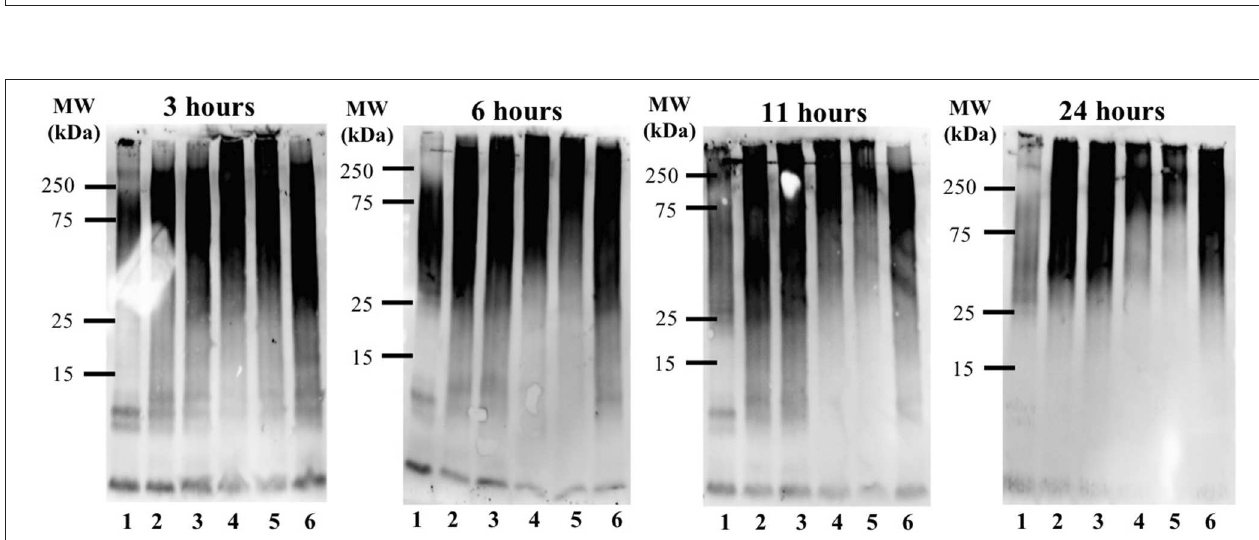
FIGURE 3 | Influence of Ru-N derivatives on the aggregation profile of A β 1 − 42 . Gel electrophoresis/Western blot of 25 µ M A β 1 − 42 and 1 eq. of Ru-N derivatives in PBS buffer (0.01M, pH 7.4) at incubation timepoints 3, 6, 11, and 24h, with constant agitation at 37 ◦ C, using anti-A β antibody 6E10. Lane 1: A β 1 − 42 ; lane 2: A β 1 − 42 + Ru-N-1 ; lane 3: A β 1 − 42 + Ru-N-2 ; lane 4: A β 1 − 42 + Ru-N-3 ; lane 5: A β 1 − 42 + Ru-N-4 ; lane 6: A β 1 − 42 + NAMI-A .